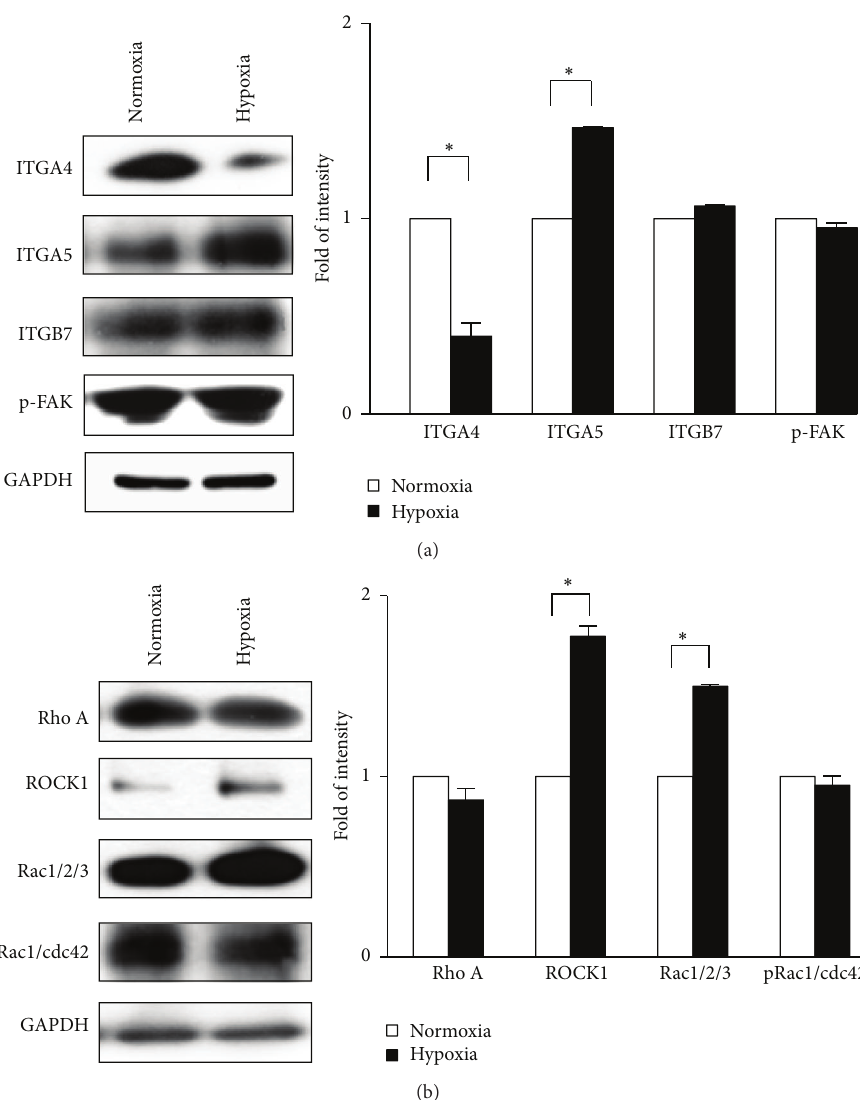
Figure 2: Expression of signaling molecules associated with cellular invasiveness including integrins and Rho GTPases under hypoxia. (a) Protein expression levels of integrins and phosphorylated FAK under normoxic or hypoxic conditions. (b) The expression levels of RhoA, ROCK1, Rac1/2/3, and phosphorylated Rac1/cdc42. GAPDH was used as the loading control. ∗ 𝑃 < 0.05 (compared with normoxic